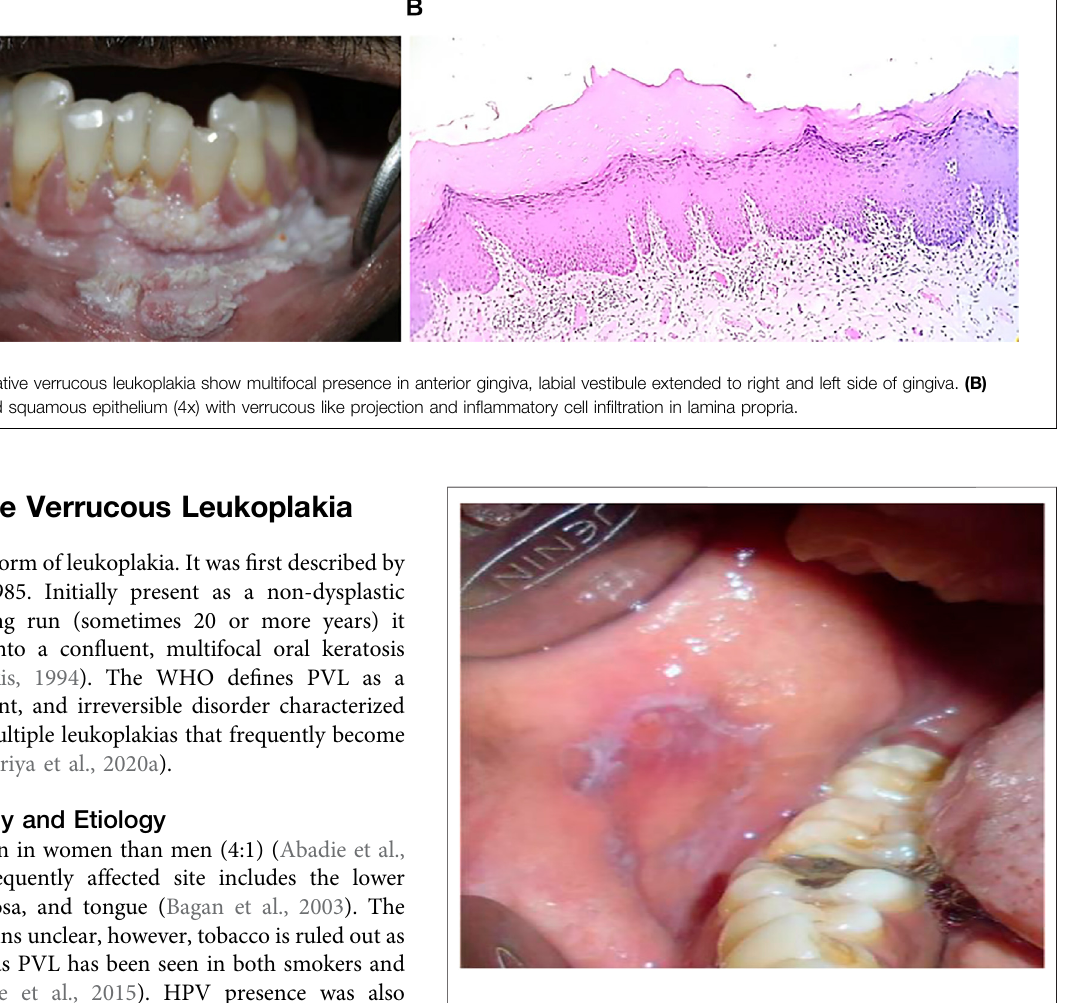
FIGURE 11 | Clinical representation of oral lichenoid